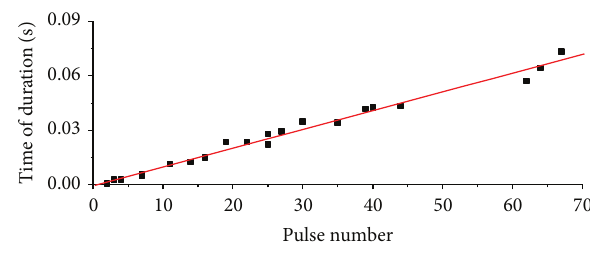
and 𝑇 pulse duration